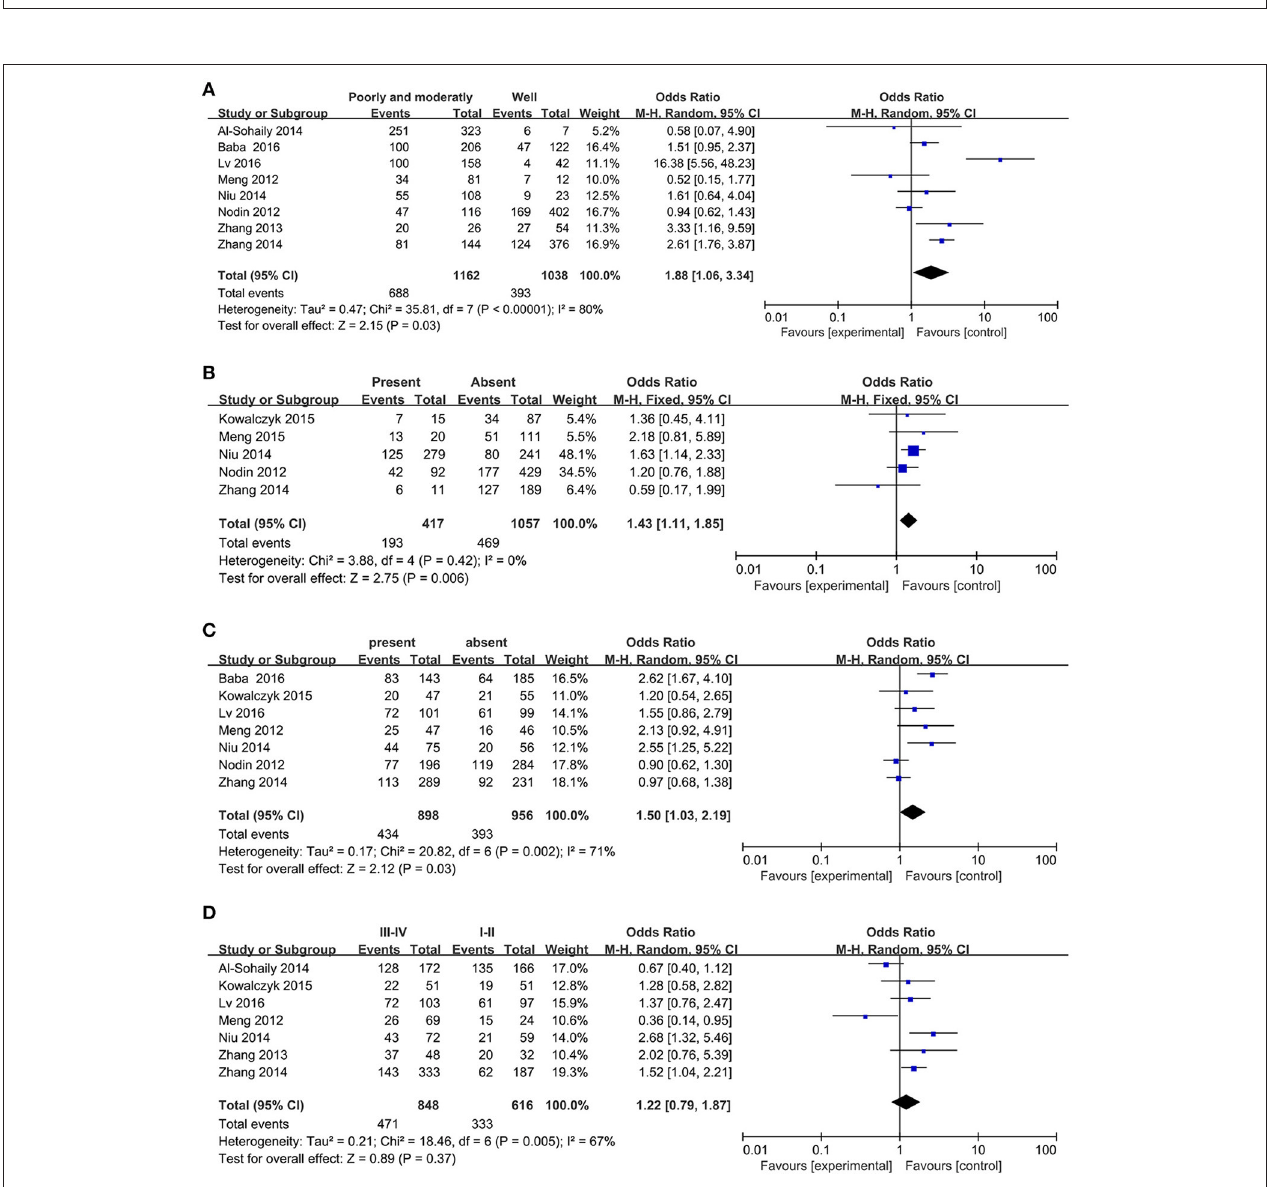
FIGURE 3 | Forest plot for the relationship between SATB1 expression levels with clinical parameters in CRC. (A) Histologic grade; (B) Distant metastasis; (C) Lymph node metastasis; (D) TNM stage.